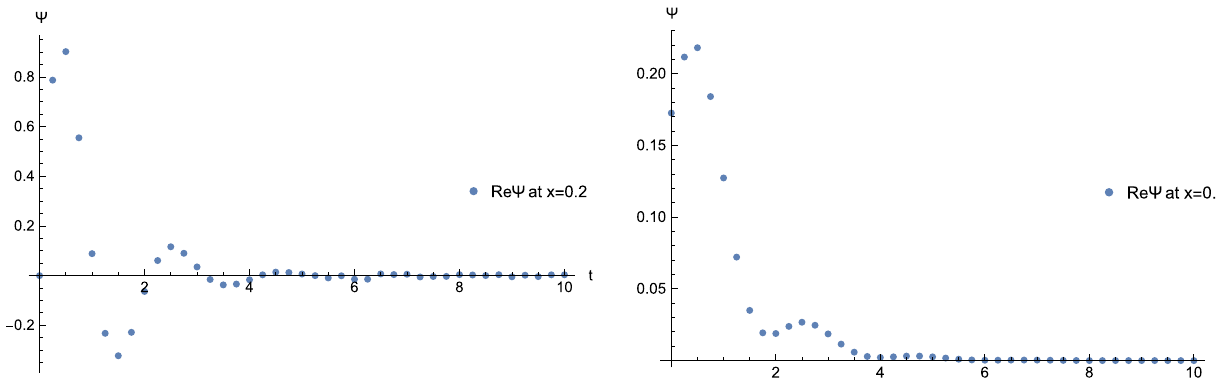
Fig. 1 The calculated time series of the toy model for two different types of sources given in Eqs. (35) and (36) are shown in the left and right plot, respectively. The calculations are carried out to generate a total of 40 points in the time series